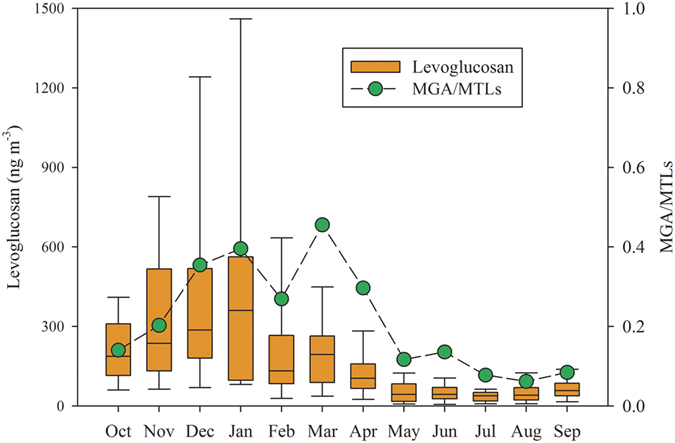
Monthly variations of levoglucosan and MGA/MTLs in China.Box with error bars represent 10th, 25th, 75th, 90th percentiles in each month. The line in the box is the median in each month. The ratio of MGA/MTLs is the median in each month.